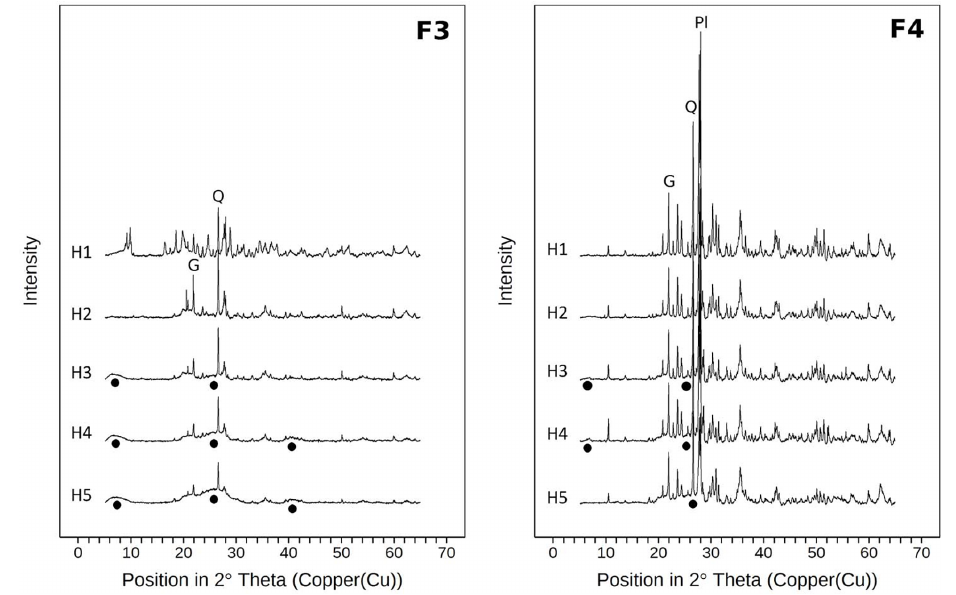
Figure 7. X-ray diffractograms (Cu-K α radiation) of the heavy fractions for all horizons of samples from the sawdust site. Fractions 3 and 4 comprise particles of densities between 1.6 and 2.0gcm − 3 (F3) and >2.0gcm − 3 (F4). All diffractograms are normalized to the same vertical scale. Circles indicate poorly crystalline material. Q marks the main quartz reflection, Pl marks the main plagioclase reflection, and G marks the main gibbsite